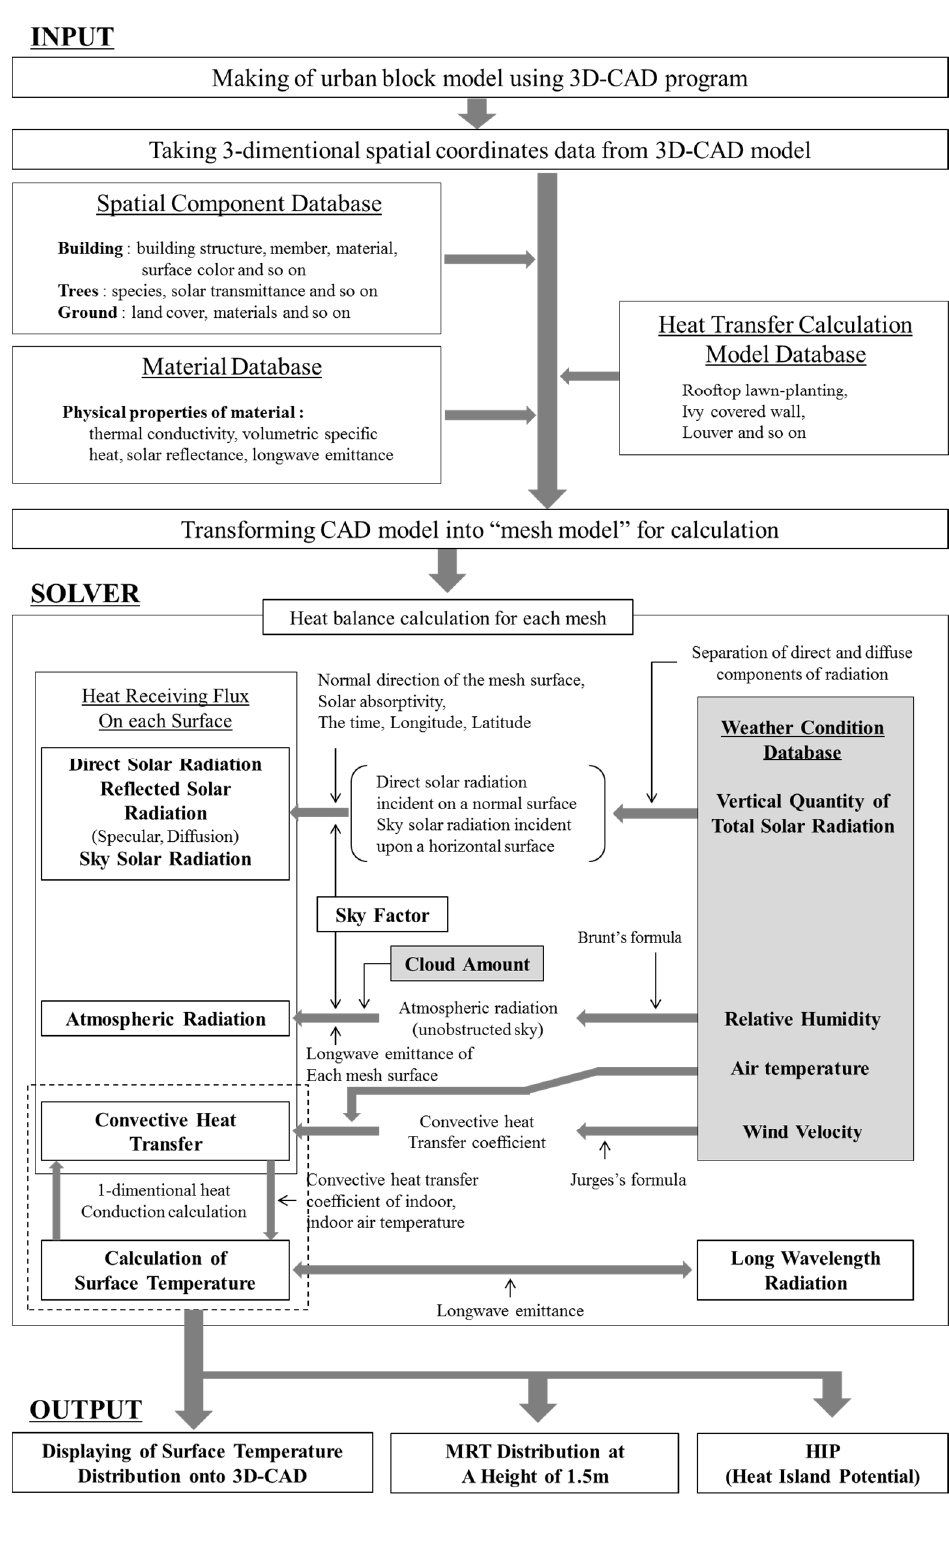
Figure 1. Numerical simulation